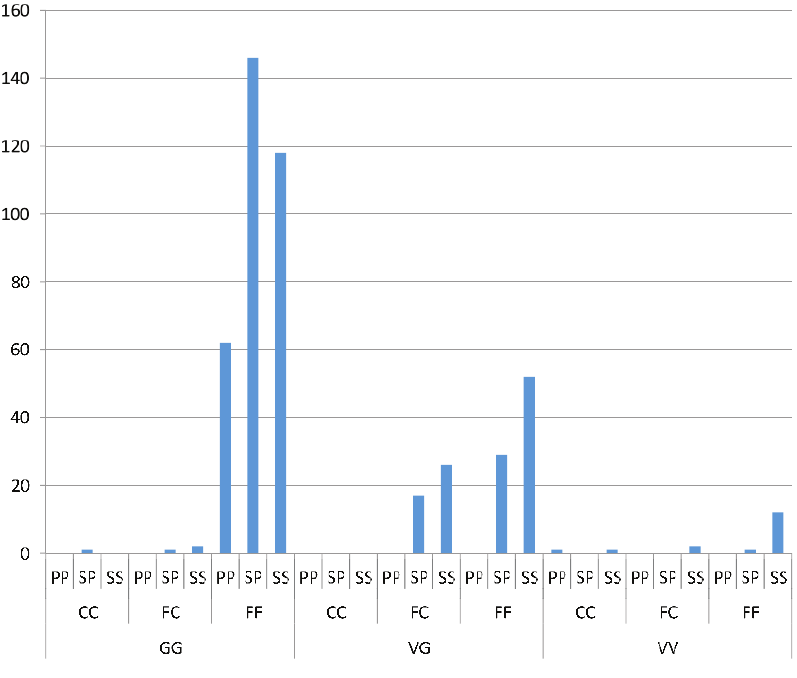
Figure A3. Genotypes of Vssc mutations V1023G, F1565C and S996P in order in individual Aedes aegypti from field samples, Yogyakarta,